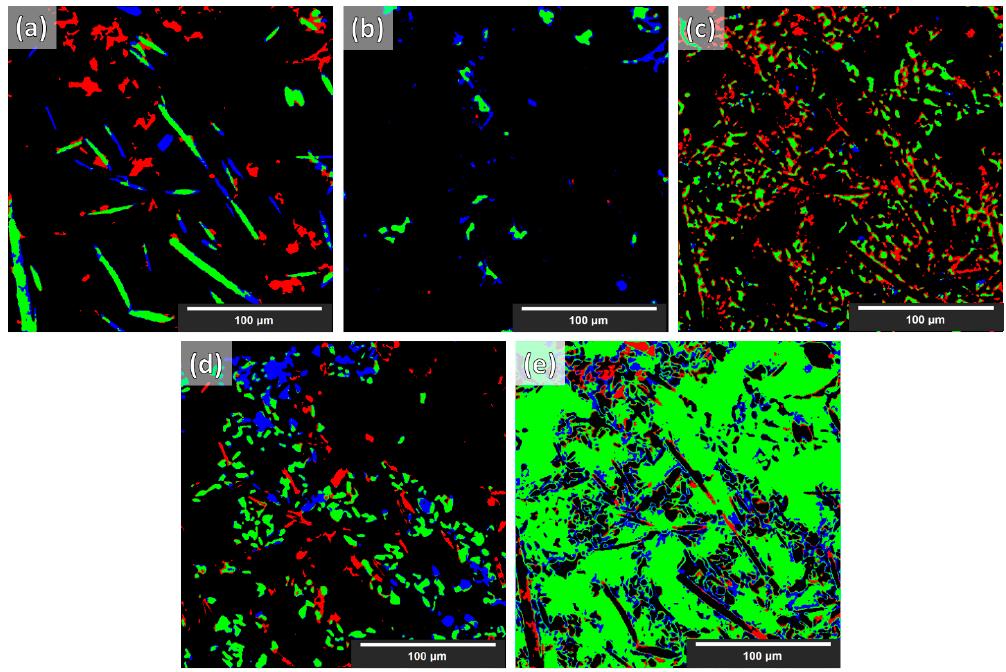
Figure 9. TP, FP, and FN error maps of the segmentation for case 4 (i.e., data augmentations + Triple_UNet + MultiView) based on NLM-conditioned experimental data. Images → ( a ) fibers; ( b ) IMs; ( c ) Si; ( d ) SiC particles; ( e ) Al matrix. Labels → red—FP; blue—FN; green—TP.